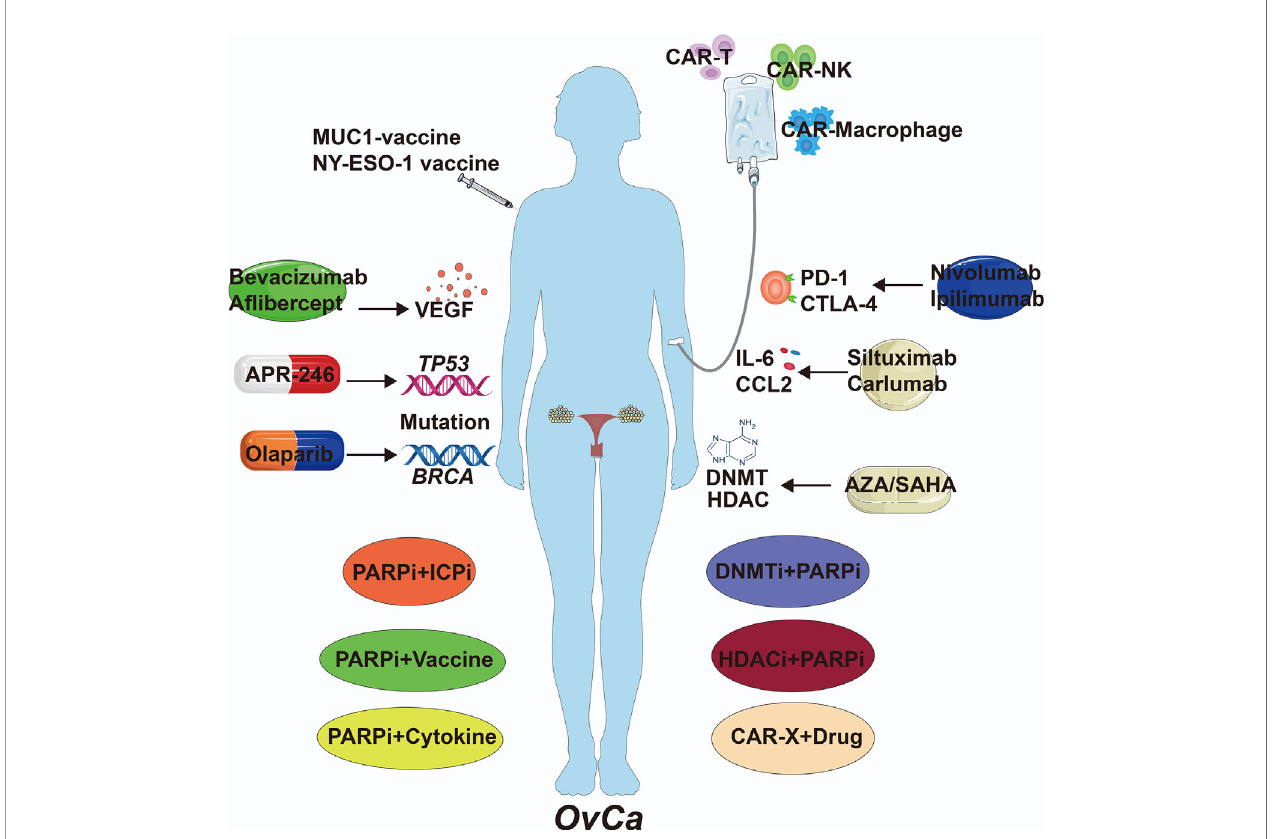
FIGURE 4 | The Clinical Therapies of OvCa. Immunological therapies of OvCa include drug, cell and combination therapy. VEGF, vascular endothelial growth factor; DNMT, DNA methyltransferase; HDAC, histone deacetylase; AZA, 5-azacytidine; SAHA, suberoylanilide hydroxamic acid; CAR, chimeric antigen